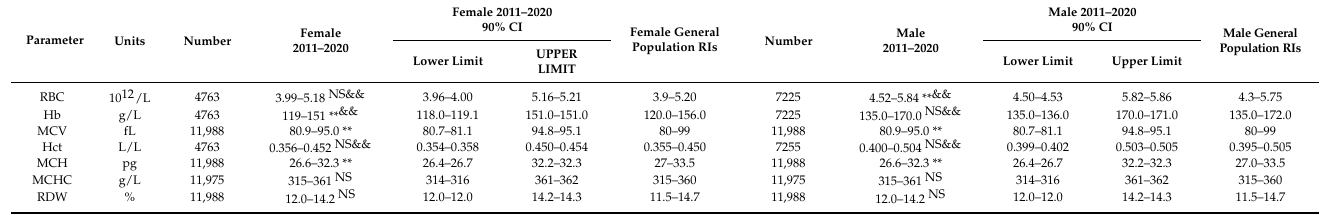
Table 3. Reference intervals (RIs) and basal values for red blood cells and associated parameters.